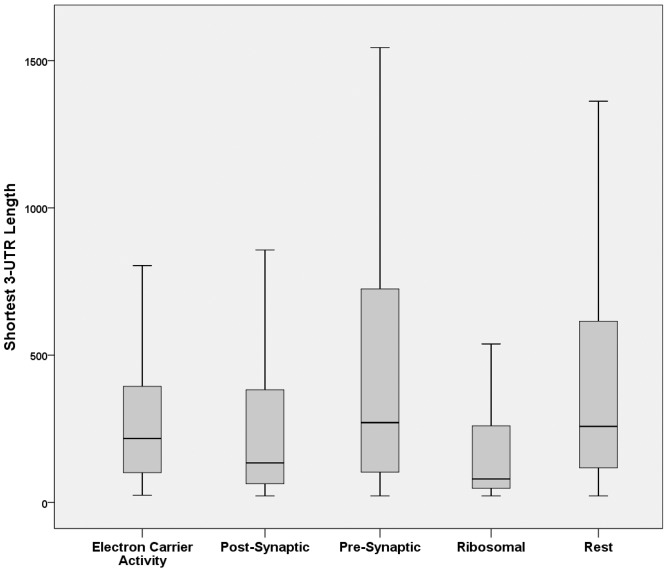
Comparative analysis of shortest 3′UTR sequences from synaptic and non-synaptic control transcript groups.Boxplots depicting 3′UTR length of the electron-carrier activity, postsynaptic, presynaptic, ribosomal and rest protein-coding transcripts with the shortest 3′UTR sequence.